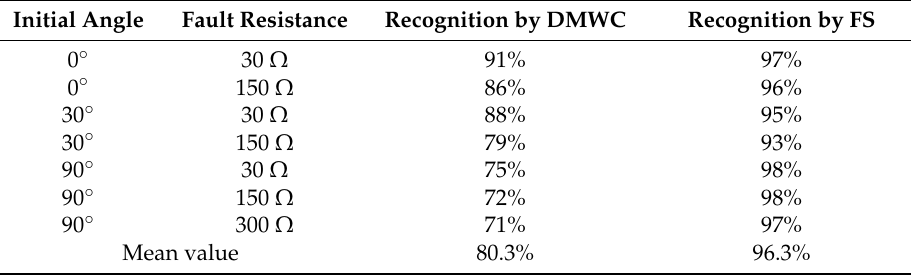
Table 7. Comparison of DMWC and FS with different fault resistances.